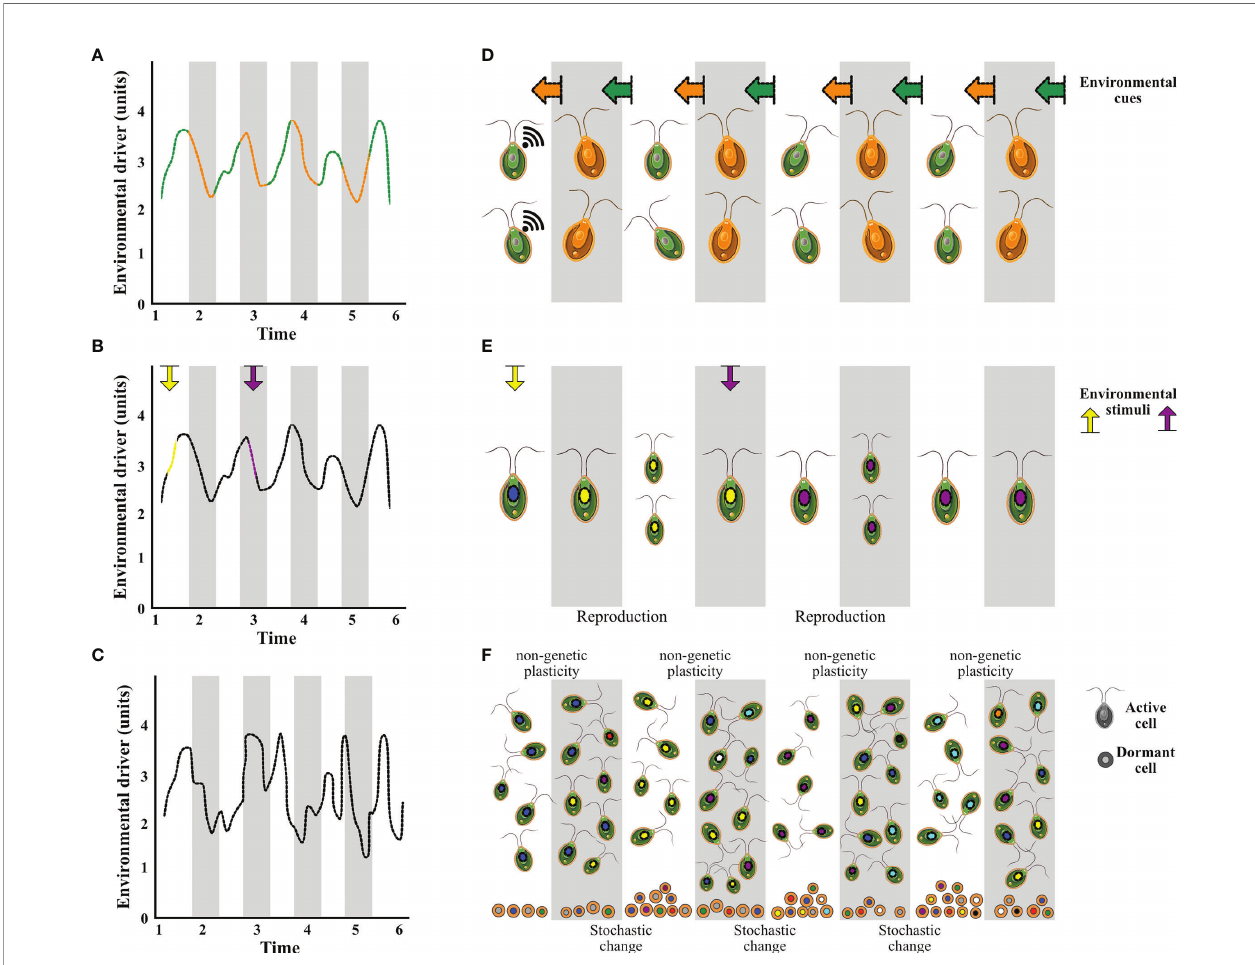
FIGURE 2 | Adaptive strategies of marine microbes to cope with short-term environmental variability are in fl uenced by the level of predictability (High: A, B ; Low: C ) of environmental change. Anticipatory and memory mechanisms (D) in which microbes can sense environmental cues (arrows in orange and green linked to predictable environmental changes, (A) that allow them to adjust phenotypically in an anticipatory manner. Direct environmental sensing-respond mechanisms (E) in which microbes exhibit phenotypic responses that correspond to their environmental condition/stimulus (yellow and purple, B ). (F) Seed banks representing the diversi fi ed bet-hedging (a.k.a. stochastic phenotypic switching) strategy, in which microbes produce long-term resting stages that act as a genetic and phenotypic reservoir that protect populations against unpredictable future conditions (C)